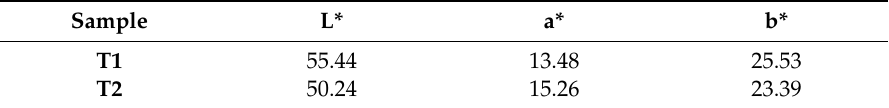
Figure 4. Absorption spectra of untreated wool (UW, gray) and dyed wool in aqueous onion skin extract in the absence (black) and presence (blue) of SB3-14 micelles. Table 1. Colorimetric coordinates of textile samples.